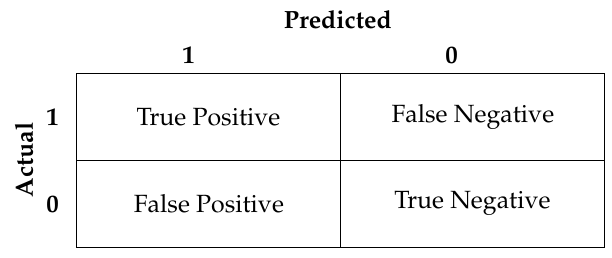
Figure 7. Confusion